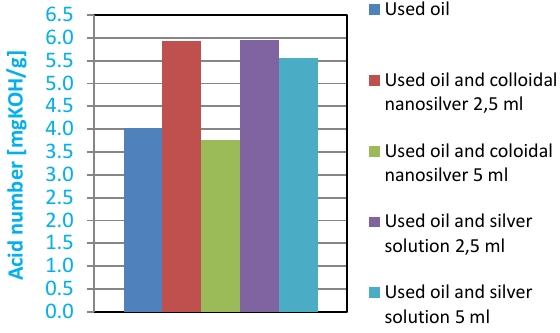
Fig. 4. Acid number of used oil and used oil with colloidal nanosilver and silver solution The situation is different when adding 2.5 ml and 5 ml of silver solution. In both cases, the acid number increases to 1.929 mgKOH/g and 1.536 mgKOH/g, respectively, in relation to the acid number value for the used oil. This means that this type of silver causes an even greater dete- rioration in the properties of the oil, although the greater amount of silver solution resulted in a lower increase in acid number, therefore the effect of adding more silver solution must be